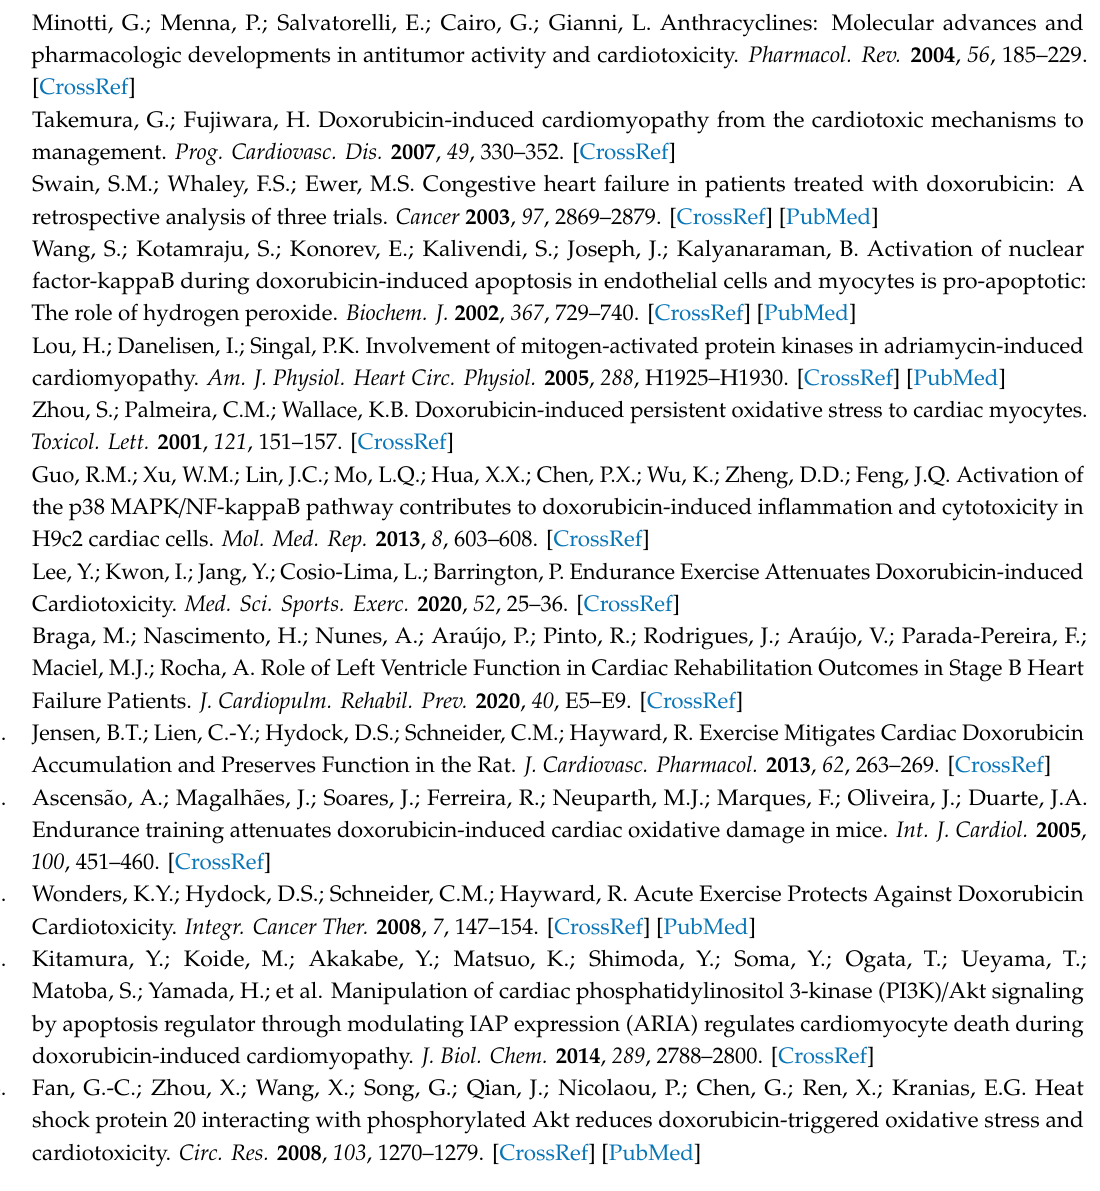
Figure S1: Detailed information about Figure 2B, Figure S2: Detailed Information about Figure 3A, Figure S3: Detailed information about Figure